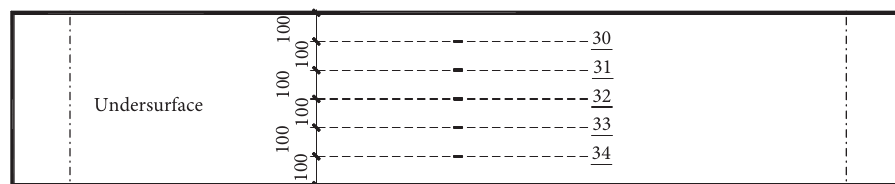
Figure 5: Arrangement of steel plate strain